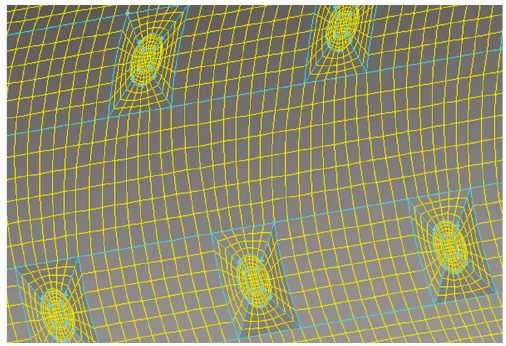
Figure 3: Grid model detail around jet